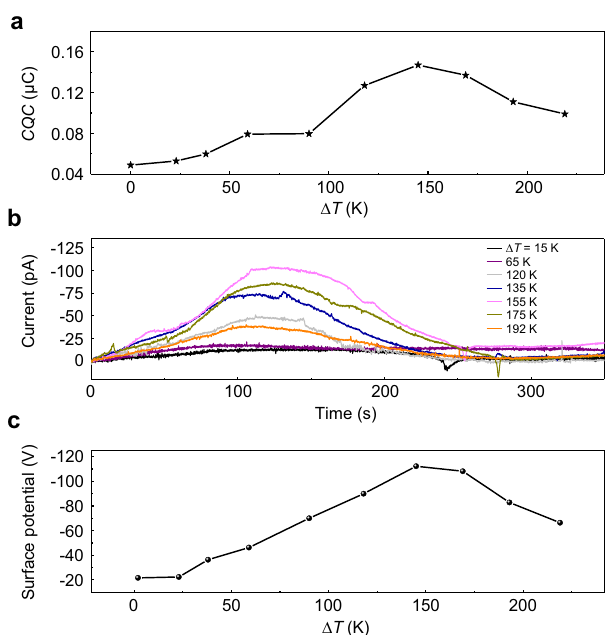
Fig. 3 Characterization of the effect of Δ T on TDNG. a The relationship between transferred charge quantities per cycle ( CQC ) of TDNG at short- circuit condition and Δ T . b The thermally stimulated discharge current of Kapton after friction at different Δ T . c The surface potential of Kapton after friction at different Δ T